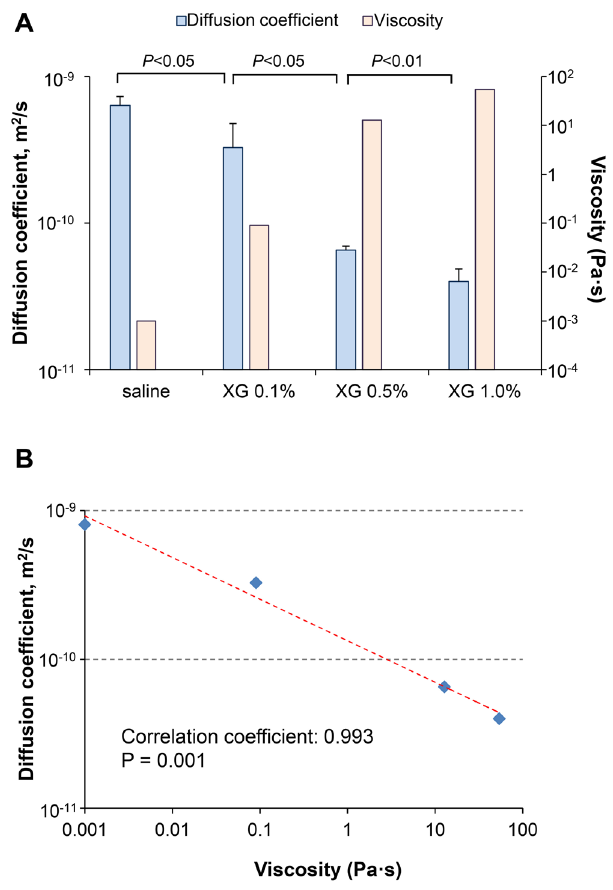
Figure 7. Evaluation of the diffusion rate of ethanol in saline and artificial mucus. ( A ) The rate (diffusion coefficient) at which ethanol molecules diffuse into xanthan gum-based artificial mucus or saline was determined (diffusion coefficient, light blue bar; viscosity, light red bar). ( B ) Scatter plot of the viscosity of artificial mucus vs. diffusion coefficient; correlations were determined using the Pearson’s correlation coefficient. XG, xanthan gum. Three independent experiments were performed and the results are expressed as the mean ± standard